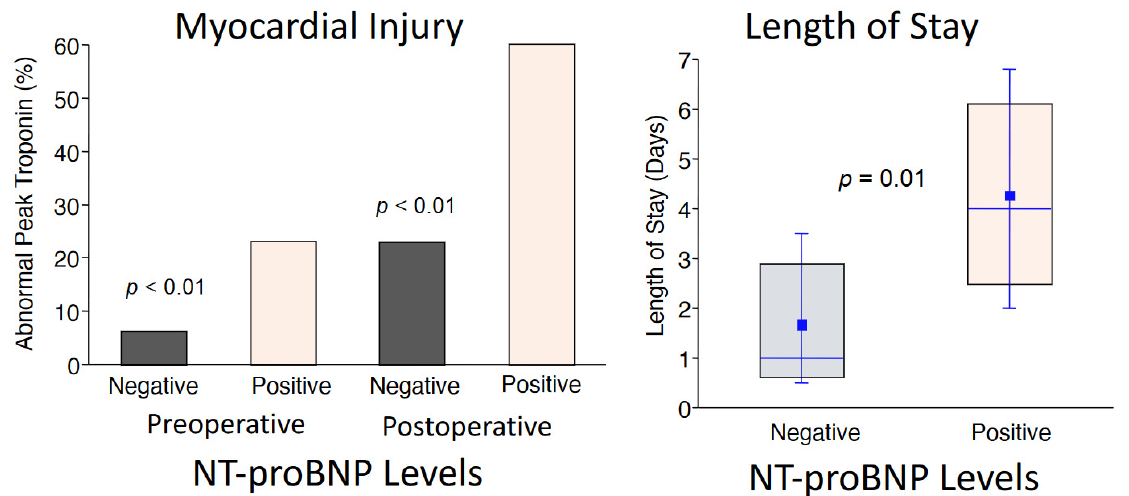
Figure 1. Among the entire group of patients undergoing elective vascular surgery ( n = 123), an elevated N-terminal pro hormone BNP (NT-proBNP) level predicted those patients who would have myocardial injury (elevated postoperative troponin level) as well as those patients who had a longer postoperative stay in the hospital. These data show the importance of NT-Pro BNP levels before and after the operation for perioperative risk-stratification [2]. Values are expressed as medians, interquartile values, and means. Permission was granted to reproduce the data.